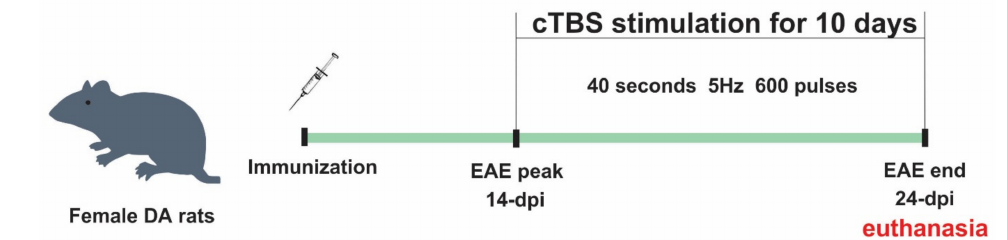
Figure 1. CTBS treatments of EAE rats. Rats were immunized for EAE at day 0 and scored and weighed every day until day 24. The first symptoms appeared around 10 dpi and peaked around 14 dpi. The animals were subjected to CTBS or sham noise artifact for 10 consecutive days from disease peak and